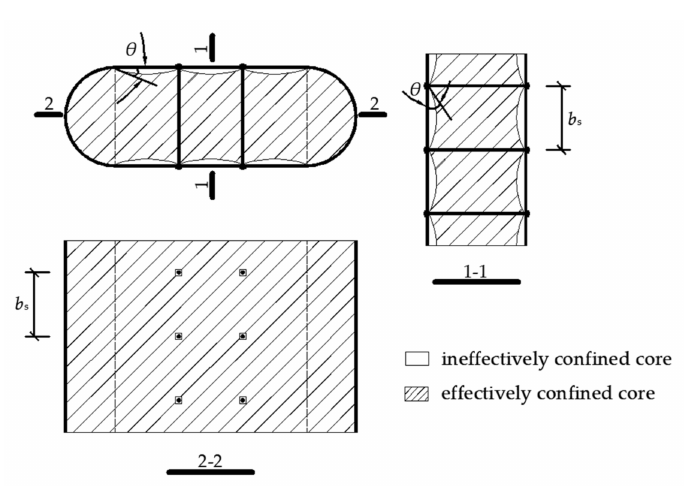
Figure 17. Effectively confined core of concrete for RRCFST with tie